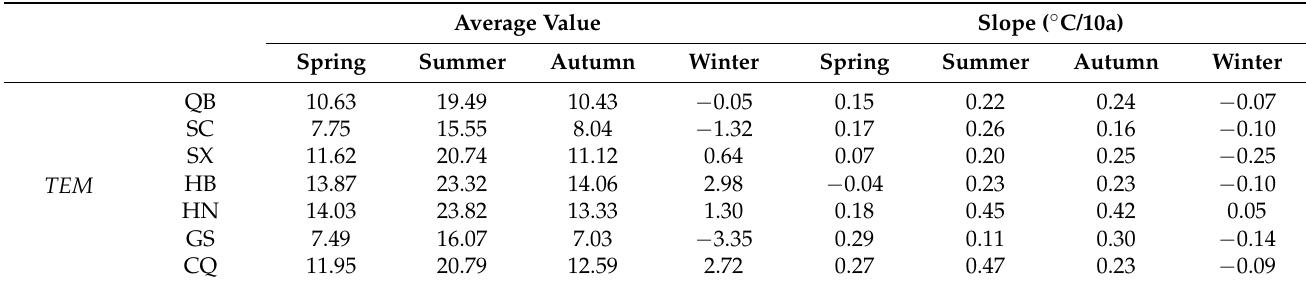
Table 6. Seasonal average and change trend rate of TEM in the QBM. Average Value Slope ( ◦